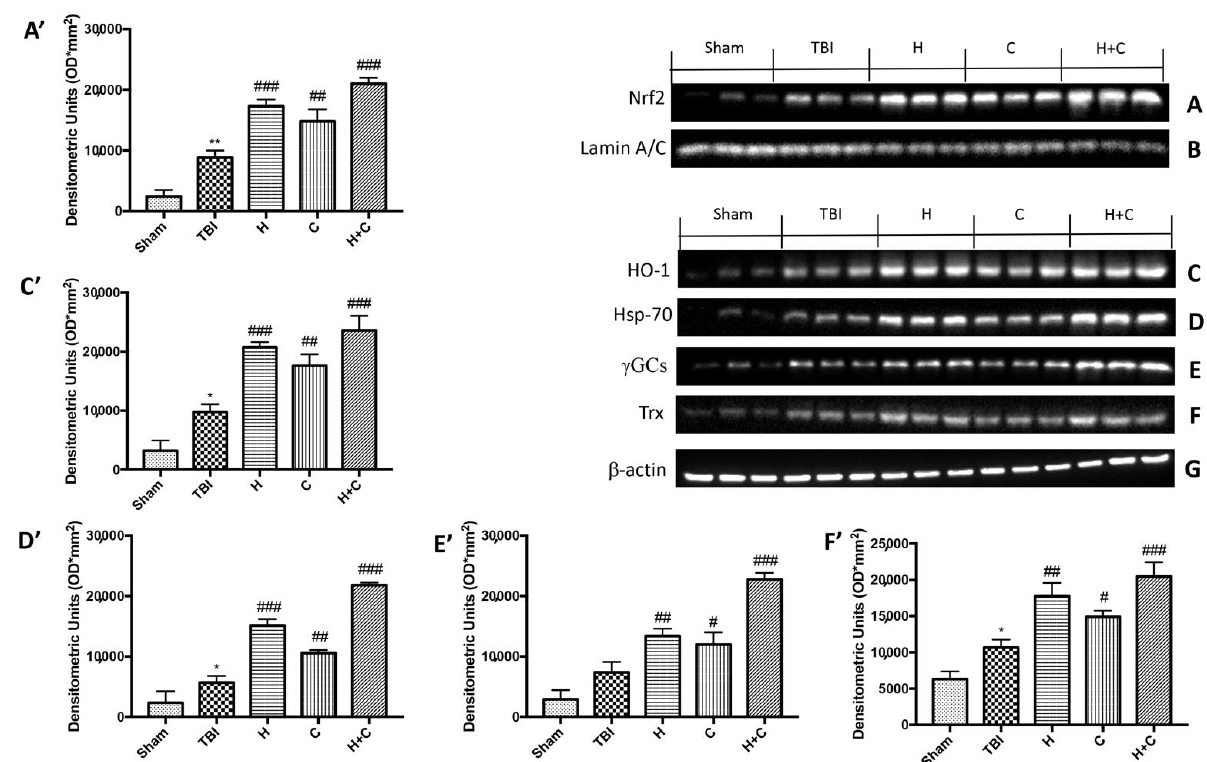
Figure 7. Effect of H. erinaceus or C. versicolor , or H. erinaceus + C. versicolor treatment on Nrf2, HO-1, Hsp-70, γGCs and Trx proteins after chronic TBI. Western blot analysis on midbrain showed that Nrf2 expression was significantly increased in the TBI group, while treatments with H, C or H + C further increased the expression of Nrf2 ( A ). HO-1 expression was increased after TBI; treatments with H, C or H + C continued to increase levels of this protein ( C ). Hsp-70 expression was increased after rotenone intoxication; treatments with H, C and especially with H + C kept the levels of this protein high ( D ). The expression of γGCs was increased in the TBI group, while treatments with H, C or H + C further increased the expression of γGCs ( E ). Finally, Trx expression was increased after TBI; treatments with H, C or H + C further increased the levels of this protein ( F ). The protein lysates were also incubated with anti-actin antibody ( G ) or laminin antibody ( B ) to verify that the quantities of the loaded samples were the same. Data are expressed as mean SEM from n = 5 mice/group. Densitometry analysis: ( A’ ) ** p < 0.01 vs. Sham; ### p < 0.001 vs. TBI; ## p < 0.01 vs. TBI; ### p < 0.001 vs. TBI; ( C’ ) * p < 0.05 vs. Sham; ### p < 0.001 vs. TBI; ## p < 0.01 vs. TBI; ### p < 0.001 vs. TBI; ( D’ ) * p < 0.05 vs. Sham; ### p < 0.001 vs. TBI; ## p < 0.01 vs. TBI; ### p < 0.001 vs. TBI; ( E’ ) ## p < 0.01 vs. TBI; # p < 0.05 vs. TBI; ### p < 0.001 vs. TBI; ( F’ ) * p < 0.05 vs. Sham; ## p < 0.01 vs. TBI; # p < 0.05 vs. TBI; ### p < 0.001 vs. TBI. Furthermore, we investigated the effect of chronic TBI and treatment with H, C or H + C in different areas of the brain. In particular, the levels of HO-1, Hsp70, γGCs and Trx, were measured by Western blot analysis, in the cortex (Cx), in the hippocampus (Hp) and in the cerebellum (Cb). In animals treated with H and C and especially with H + C, a significant increase of HO-1 was observed in all regions of the brain examined, while this significant increase was not observed in the TBI group. Basal levels were observed in the control animals (Figure 8A–C, see relative densitometry analysis A’, B’, C’).